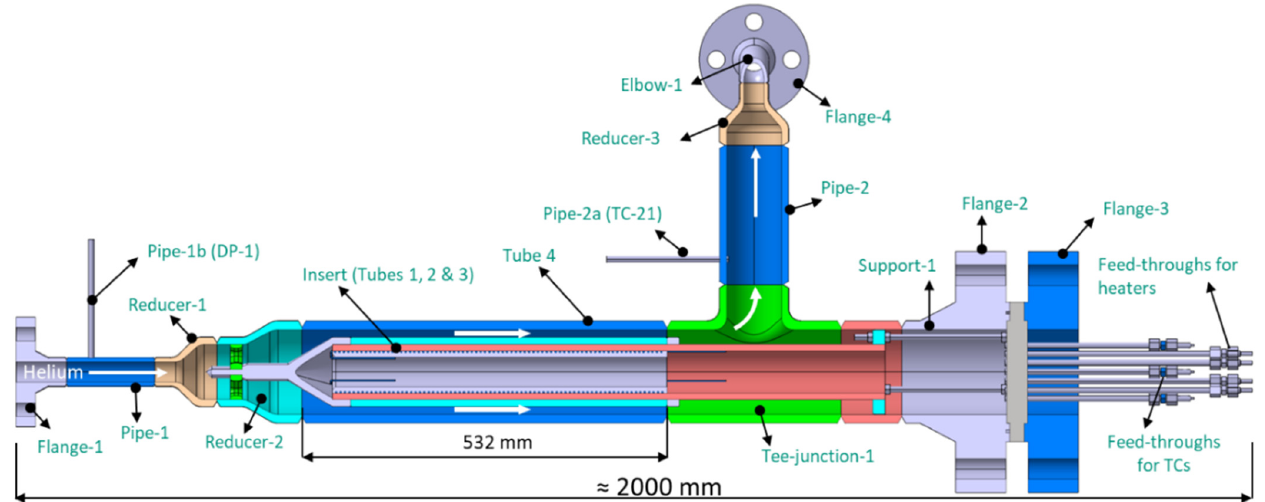
Figure 1. The CAD design of the pin mock-up.